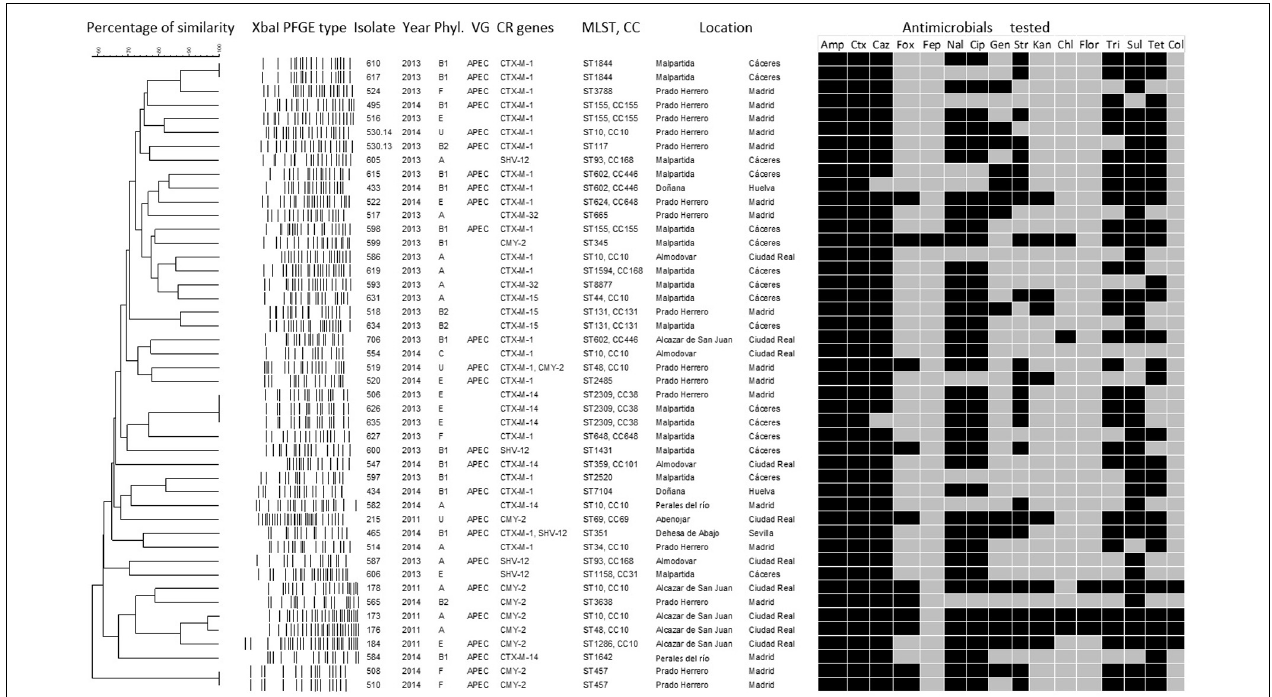
FIGURE 2 | Phenotypic and genotypic characteristics of the cephalosporin-resistant E. coli isolates: dendrogram showing the genotypic relationships of the different Xba I-types of the isolates. Further characteristics are also shown: year of isolation phylogroup (Phyl. U, unidentified phylogroup), virulence-associated genes (VG) and cephalosporin and colistin resistance genes (CR), sequence type (ST); clonal complex (CC) and sampling location. The antimicrobial agents tested are also displayed and the black boxes below their abbreviated designations are indications for a non-wild-type phenotype. Amp, ampicillin (WT ≤ 8 mg/L); Ctx, cefotaxime (WT ≤ 0.25 mg/L); Caz, ceftazidime (WT ≤ 0.5 mg/L); Fox, cefoxitin (WT ≤ 8 mg/L); Fep, cefepime (WT ≤ 0.125 mg/L); Nal, nalidixic acid (WT ≤ 16 mg/L); Cip, ciprofloxacin (WT ≤ 0.064 mg/L); Gen, gentamicin (WT ≤ 2 mg/L); Str, streptomycin (WT ≤ 16 mg/L); Kan, kanamycin (WT ≤ 8 mg/L); Chl, chloramphenicol (WT ≤ 16 mg/L); Ff, florfenicol (WT ≤ 16 mg/L); Tm, trimethoprim (WT ≤ 2 mg/L); Sul, sulfamethoxazole (WT ≤ 64 mg/L); Tet, tetracycline (WT ≤ 8 mg/L); Col, colistin (WT ≤ 2